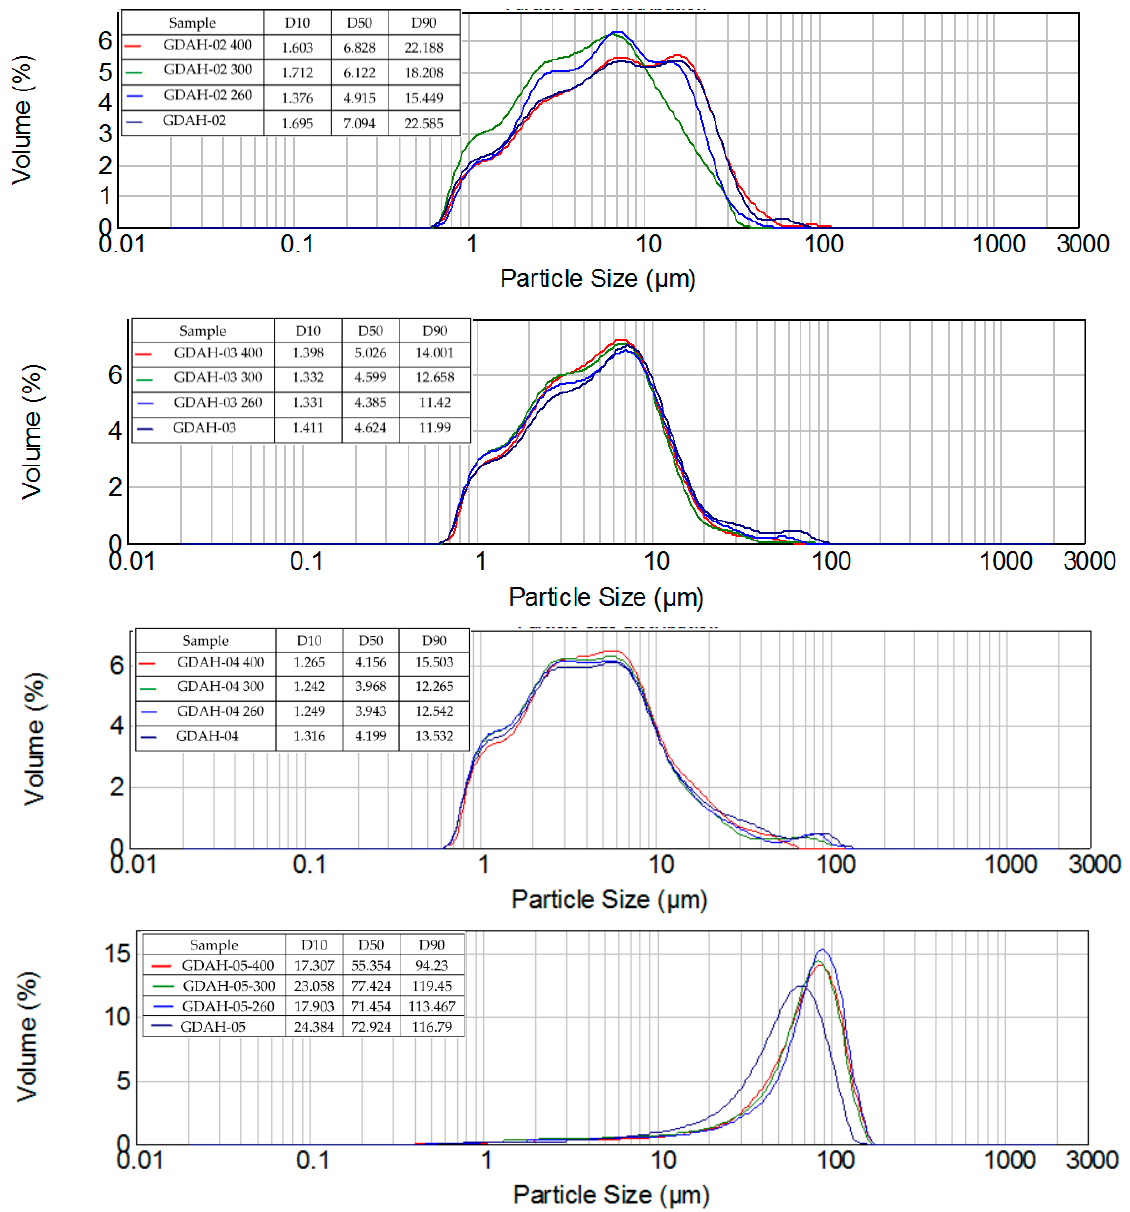
Figure 3. Particle size distributions for each powder, overlapped before and after calcination. The inserts show the D10, D50, and D90 numeric values for each sample before and after thermal treatment at 260 °C, 300 °C, and 400 °C.